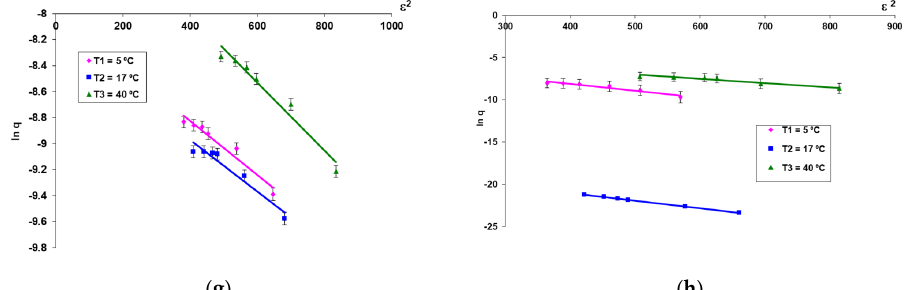
Figure 5. Linearized form of Freundlich ( a , b ), Langmuir I ( c , d ), Langmuir II ( e , f ), and DR ( g , h ) plots for the methylene blue cationic dye on biosorbent based on Saccharomyces pastorianus residual biomass obtained by a simple dripping technique ( a , c , e , g ) and by encapsulation using a Buchi microencapsulator ( b , d , f , h ) in sodium alginate. Conditions: pH = 3, contact time = 24 h, biosorbent amount: 0.26 g/L (with 5%d.w. for φ 1 = 4 mm), and 0.15 g/L (with 5% d.w. for φ 2 = 1.5 mm); diameter of granules: φ 1 = 4 mm ( a , c , e , g ) and φ 2 = 1.5 mm ( b , d , f , h ) at three temperatures: 5°, 17°, and 40 °C. Table 2. Characteristic parameters for the biosorption of methylene blue cationic dye onto biosorbent based on residual biomass of Saccharomyces pastorianus immobilized in alginate matrix. Isotherm